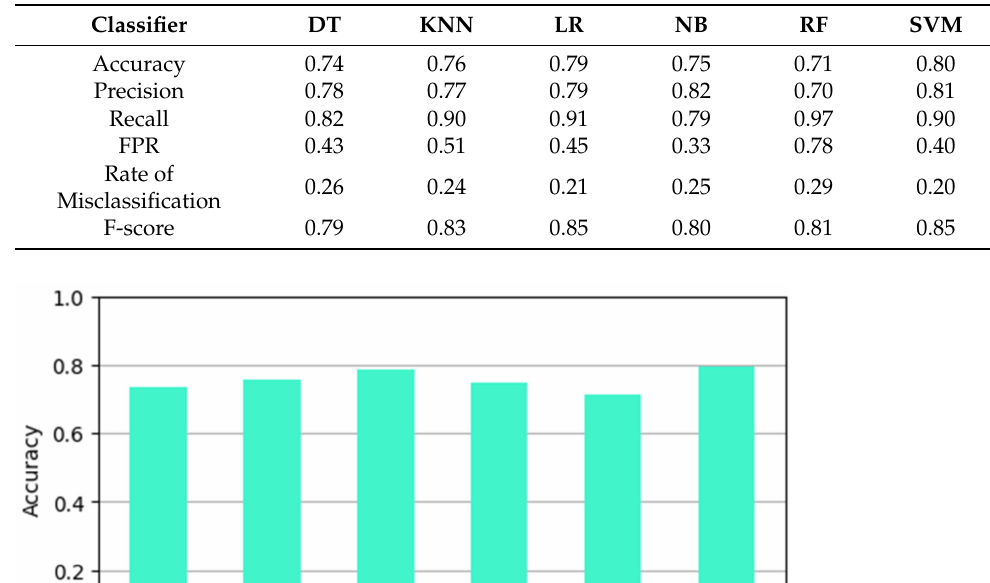
Table 3. Classification performance of ML classifiers on COVID-19 Fake News dataset.